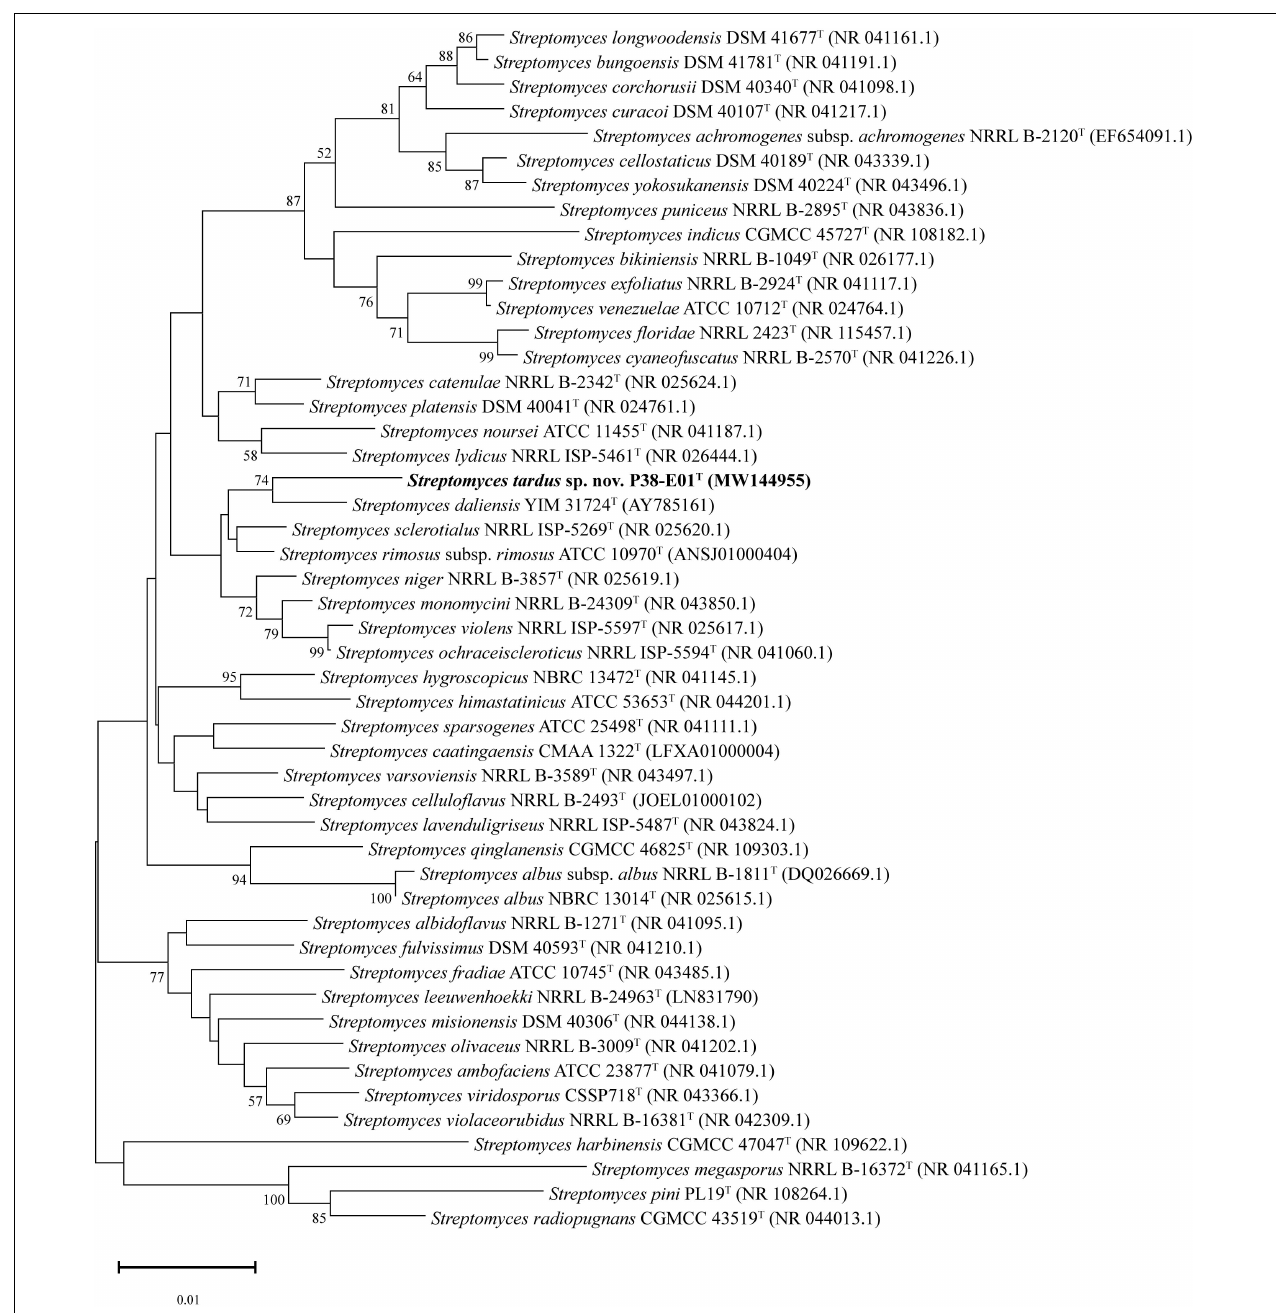
FIGURE 2 | Neighbor-joining tree based on 16S rRNA gene sequences showing the relationship between strain P38-E01 T and related taxa. Only bootstrap values above 50% (percentages of 1,000 replications) are indicated. Bar, 0.01 nucleotide substitutions per